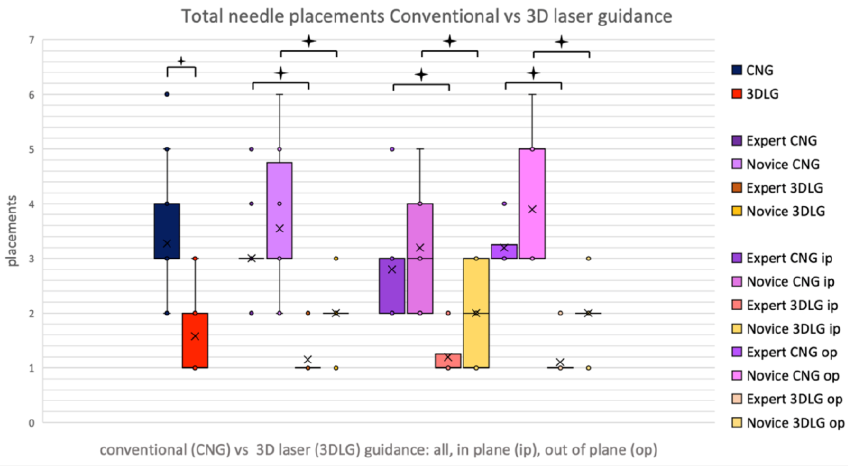
Figure 6. Total needle corrections for conventional needle guidance (CNG) and 3D laser guidance (3DLG), for expert and novice, in in-plane and out-of-plane procedures. In the pooled data of the expert and novice, the absolute deviation decreased from a mean of 3.81 ± 1.74 mm using CNG to 3.41 ± 1.14 mm ( p = 0.113) using 3DLG, and angular deviation decreased from 2.85 ± 1.87 ◦ to 2.18 ± 1.43 ◦ ( p = 0.109), respectively (Figures 7 and 8). The novice showed a significant decrease of absolute deviation from 4.21 ± 1.73 to 3.44 ± 1.11 mm when using laser guidance ( p = 0.037). The expert was not significantly more accurate than the novice, neither with CNG nor with 3DLG (Figure 8).